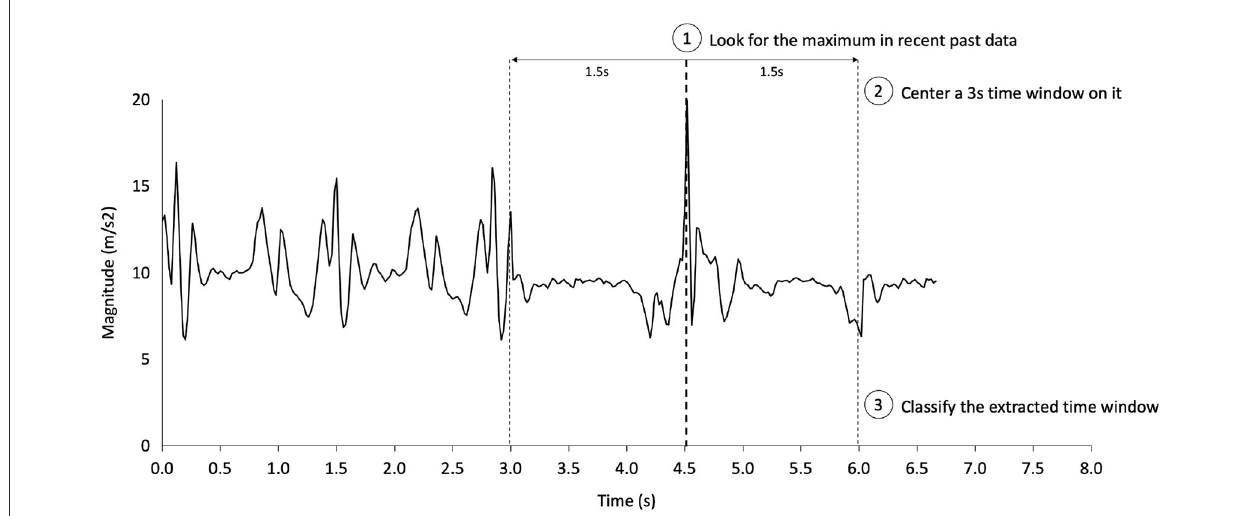
FIGURE7 One-step in our proposal for real-time fall detection. This step can then be re-executed at the desired frequency, up to the smartphone’s computing power limitations.